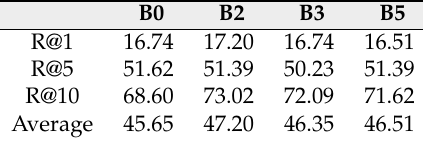
Figure 10. Unsuccessful scenarios ( a and b ) of text-to-image retrieval.